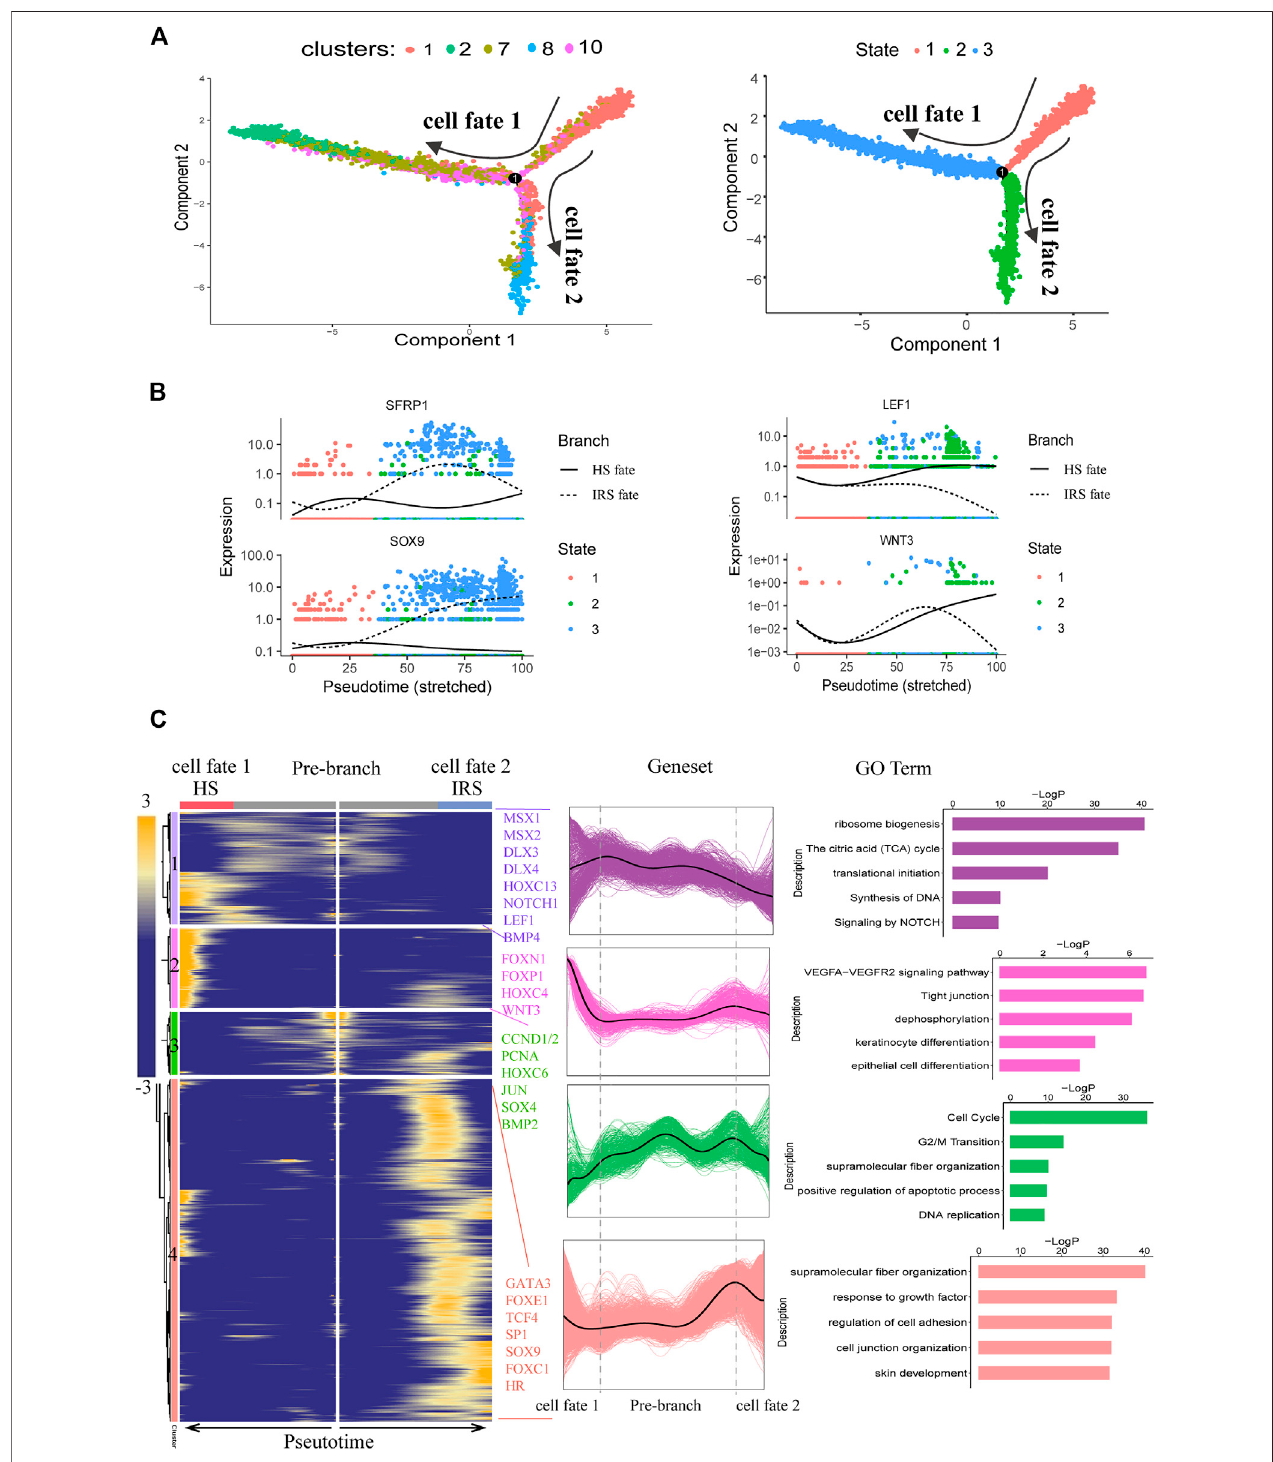
FIGURE 4 | Dissecting IRS and hair shaft fate commitment from matrix precursors. (A) Pseudotime visualization of the hair shaft and IRS fate decisions in the pseudotime trajectory. (B) The expression pro fi les of SFRP1, SOX9, LEF1, and WNT3 along pseudotime. Cells are color-coded with cell states, and the solid line represents hair shaft fate, while the dashed line represents IRS fate. (C) Heatmap and Go analysis of branch-speci fi c DEGs along pseudotime. Cell fate 1 indicates IRS fate and cell fate 2 indicates hair shaft fate.